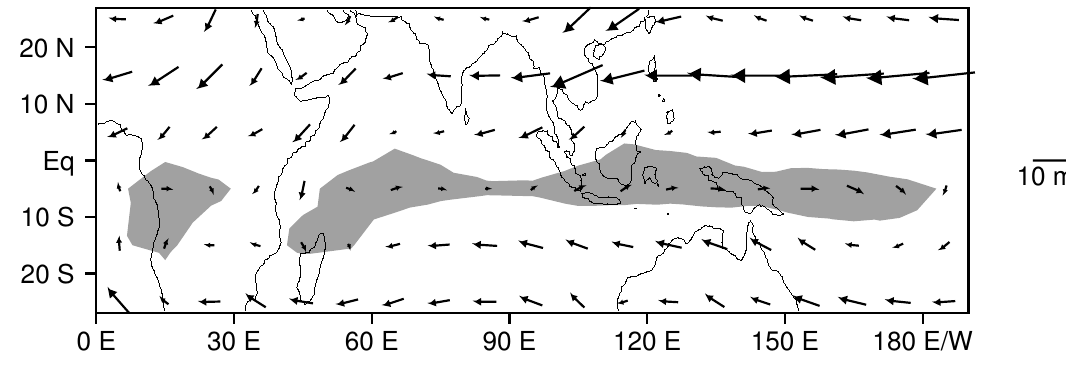
Figure 3. Average 850 hPa flow for December through March for the lower-resolution LAM simulation with regions of westerlies shaded light